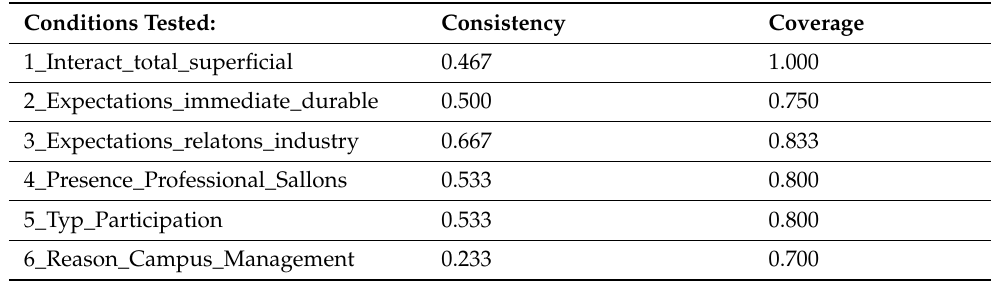
Table A2. Necessary